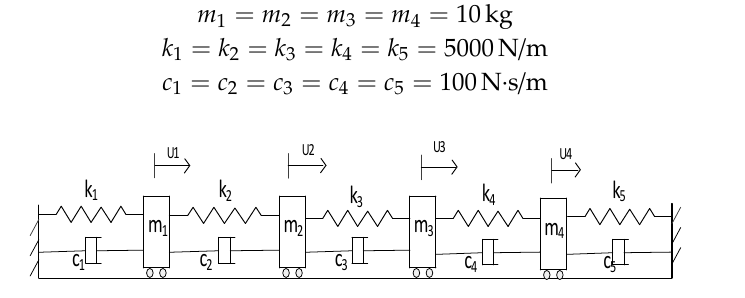
Figure 4. Four-degree-of-freedom system.